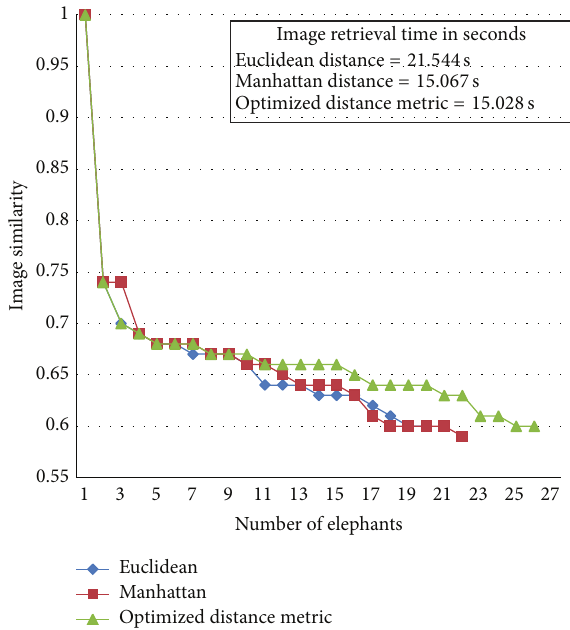
Figure 10: Image similarity metric